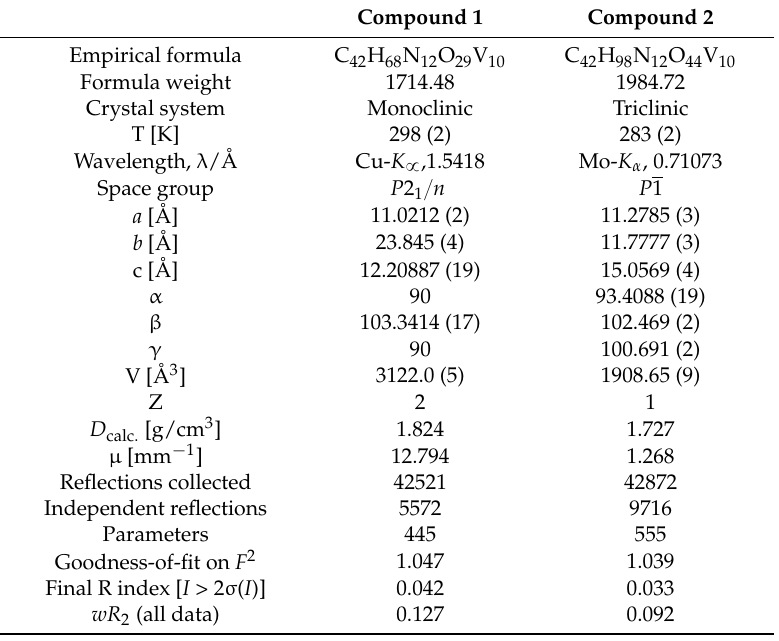
Table 3. Selected crystal data and details of the structure determination for the two compounds.